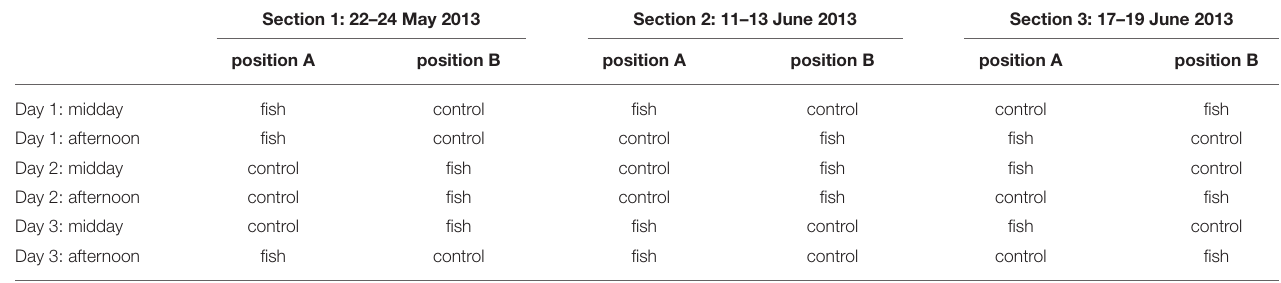
TABLE 1 | Chronological sequence of stimuli presentation (position for fish/control changed randomly between sessions).